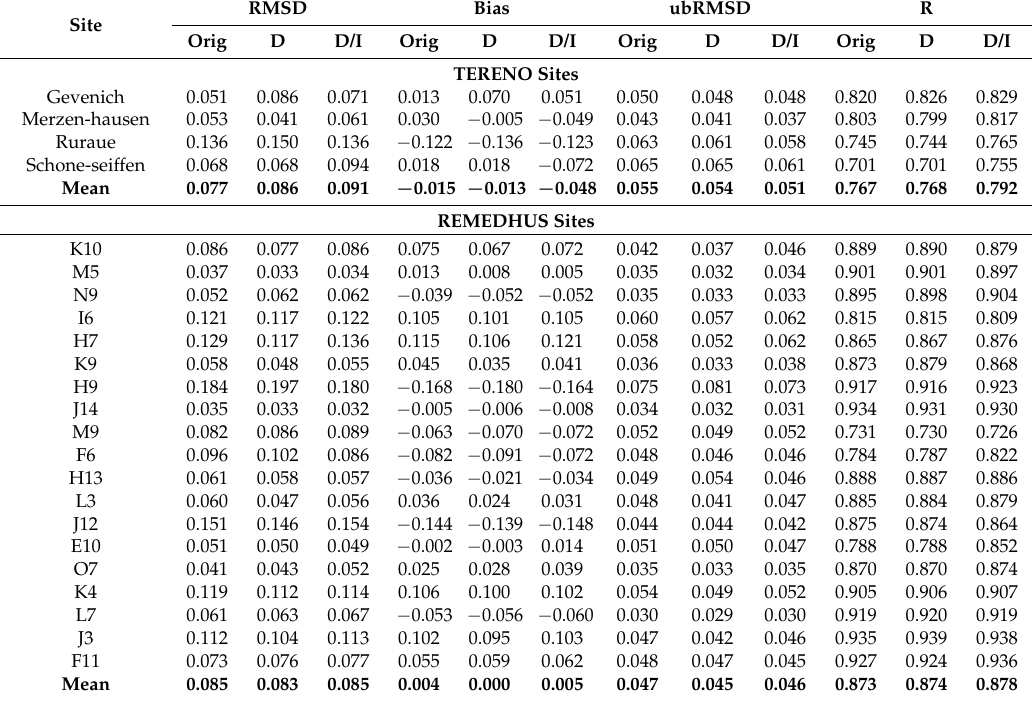
Table 2. Temporal validation metrics of SMAP downscaling results in the TERENO and REMEDHUS networks. Orig is the original SMAP coarse product, D is the downscaled result, and D/I is the interpolated and downscaled